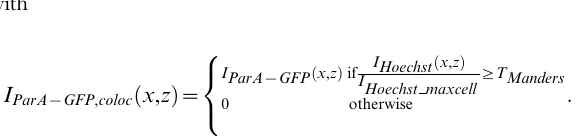
S1 Fig par2 protein functionality and expression levels. ( A ) Plasmid loss-frequency assay showing pFS21 stabilisation to wild- type levels by the recombinant par2 locus encoding parB::sfGFP , confirming functionality of the fluorescent fusion protein. Plasmids used are pRBJ200 ( par - , red), pFS19 ( par2 + , black) and experimen- tal vector pFS21 ( parC1 + , parA + , parB::sfGFP , parC2 + , green), n=2, error bars: standard error of the mean. ( B ) Representative section of semi-quantitative Western blot used for approximating ParA molecule numbers in vivo . Cell lysate samples of strain KG22 carrying a mini-R1 plasmid lacking (pRBJ200) or containing par2 (pGE2) were compared to plasmid-free KG22 cell lysate mixed with known amounts of purified His6 ParA. Standard curve generated from intensity measurements from this blot has R 2 =0.965. Band intensities were measured and quantified using the ImageQuant TL 1D Gel Analysis Software, (n=3). ( C ) Scatter plot of ParA-GFP total fluorescence signal in single WT cells as a function of cell volume, when expressed from an inducible promoter ( P lac ). The different color labels indicate the number of plasmid foci. Plasmids: pSR233 (mini-R1, par2 + , P lac ::parA::eGFP, tetO120 ) and pSR124 ( P BAD ::tetR::mCherry ). ( D ) Scatter plot of ParB-GFP total fluores- cence signal in single WT cells as a function of cell volume, when expressed from its native promoter. Plasmid: pFS21 ( parC1 + , parA + , parB::sfGFP , parC2 + ); color labeling as in ( C